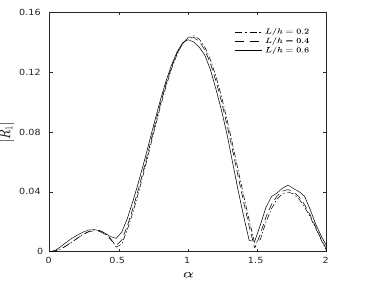
Figure 11. | R 1 | versus α for different values of plate length with l 1 /h = 0 . 01 ,c 0 /h = 0 . 1 ,M = 2 ,Kh = 0 . 25.